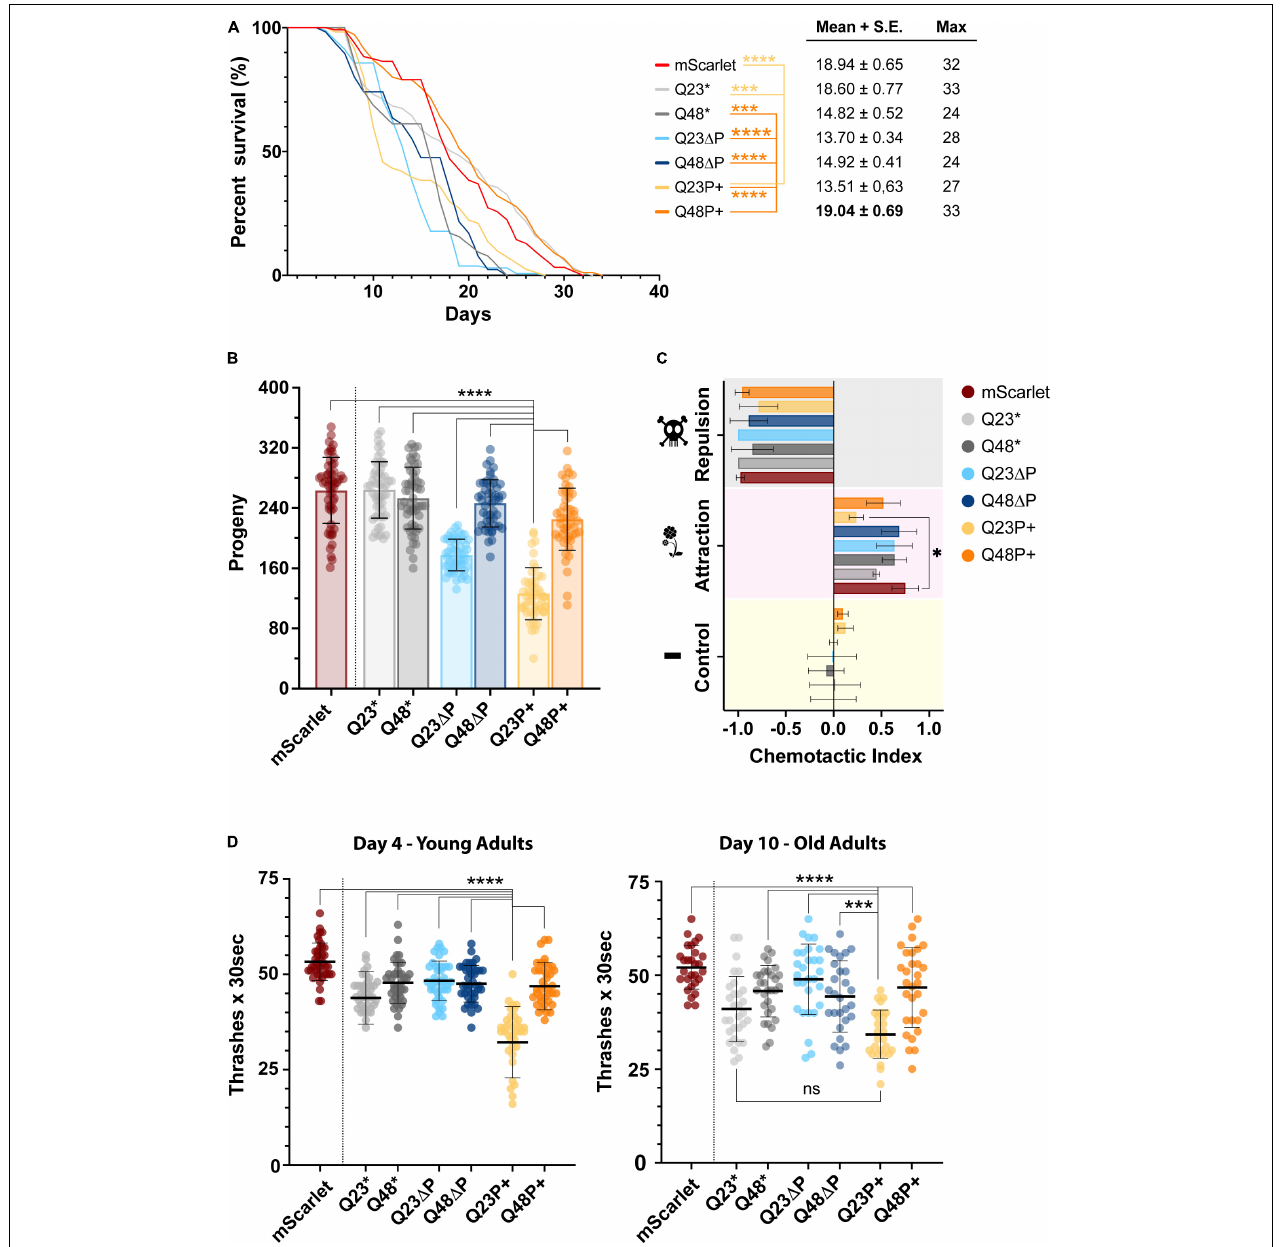
FIGURE 5 | The expanded proline is beneficial in vivo in the presence of pathogenic, but not physiological polyQ tracts. (A) Lifespan assay, illustrated with a Kaplan-Mayer plot, of selected C. elegans HTTEx1 mutant strains alongside the mScarlet control strain. Three independent repeats were performed of at least 120 nematodes each. On the right are shown the mean and standard error, and the maximum lifespan values for each strain. For significance a log-rank test was performed ( ∗∗∗ p < 0.000001; ∗∗∗∗ = p < 0.0000001 ). Only selected values of significance are shown, for a full table of significance refer to Supplementary Table 3 . (B) Scatter dot plot with bar of the progeny assay performed for selected C. elegans HTTEx1 strains and mScarlet control. The average number of offsprings recorded from three independent repeats, of 20 nematodes each, is shown as mean ± SD. Significance is calculated performing a one-way ANOVA followed by Tukey’s post hoc test and assuming 95% confidence interval ( ∗∗∗∗ = p < 0.0001 ). (C) Grouped bar plot of chemotactic assay performed on selected C. elegans HTTEx1 mutant strains alongside the mScarlet control strain. Shown is the mean ± SD of three independent repeats. The chemotaxis index is calculated between the whole nematode plate cohort and the nematodes present on the test substance quadrant, either an attractant (1% benzaldehyde), a repellent (50% benzaldehyde) or a control substance (EtOH). Significance was tested with a one-way ANOVA followed by Tukey’s post hoc test and assuming 95% confidence interval ( ∗ = p < 0.05 ). (D) Scatter dot plot of the thrashing assay performed on selected C. elegans HTTEx1 strains and mScarlet control strain, on young day 4 nematodes and on old day 10 nematode. The average number of thrashes performed in M9 liquid medium every 30 s is shown as mean ± SD. Between 30-45 nematodes per strain were analyzed in three independent repeats. For significance, a one-way ANOVA followed by Tukey post hoc test assuming 95% confidence interval was performed ( ∗∗∗ = p < 0.001 ; ∗∗∗∗ = p < 0.0001 ). For clarity, only selected significance results are shown for figures (B) and (D) , for a full list of significance refer to Supplementary Table 4